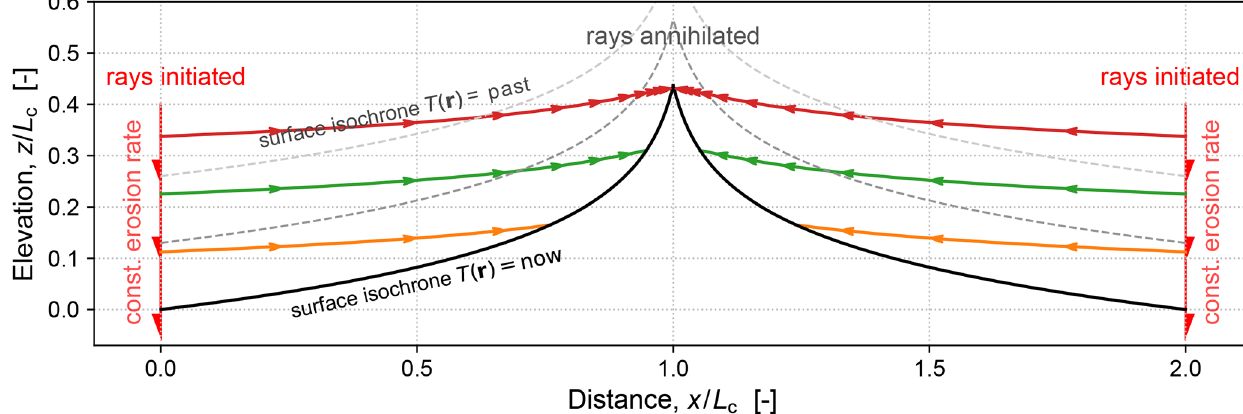
Figure 6. Ray tracing of erosion using Hamilton’s equations (Sects. 3.12 and 4.2), illustrated here for a 2D landscape transect. The geomor- phic surface Hamiltonian is solved over the left-hand half-domain, ranging from an exit boundary at x = 0 up to a drainage divide at x = L c (see Fig. 2). A fixed divide is enforced by mirroring this profile over the right-hand half-domain (for L c ≤ x ≤ 2 L c , such that symmetrically generated rays annihilate each other at a cusp formed at x = L c . The boundary condition imposed at x = 0 (and mirrored at x = 2 L c ) is a constant vertical erosion rate ξ ↓ 0 , mimicking the behaviour of a vertical normal fault slipping at a constant rate ξ ↓ 0 at the boundary. The initial value of the front slowness covector (cid:101) p at x = 0 is chosen such that the surface tilt β 0 and vertical slowness p z this rate. The model therefore simulates a horst block undergoing constant uplift and consequent erosion. Model topography is obtained by constructing surface isochrones { T ( r ) } from the rays. Since rays are traced only from the boundary and not from an initial surface, the isochrones are time-invariant. The standard term for such topography is “steady state”, but the term is somewhat misleading here because the Hamiltonian dynamical system has no stable point.